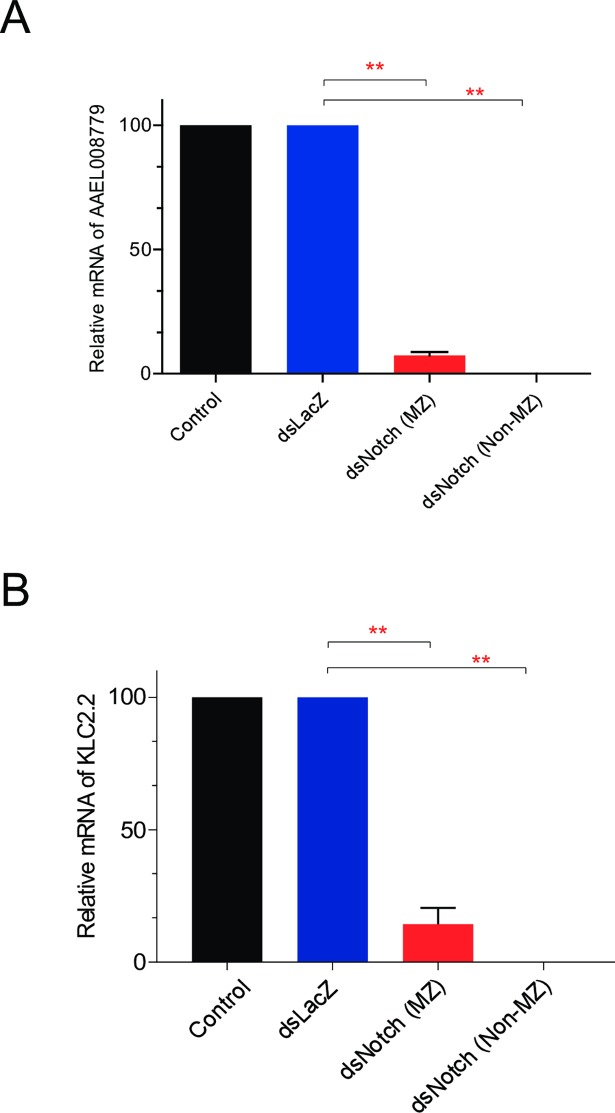
Quantitative PCR analysis of the expression of a sperm-specific and an embryo-specific gene.(A) Total RNA extracted from eggs of control, dsLacZ-, and dsNotch-treated mosquitoes, separated into melanized (MZ) and non-melanized (non-MZ) groups. (B) Total RNA of eggs from control and dsNotch-treated mosquitoes extracted at 5 h after egg-laying, representing melanized (MZ) and non-melanized (non-MZ) eggs. Data were analyzed with ANOVA (** = p < 0.001) comparing groups among brackets.